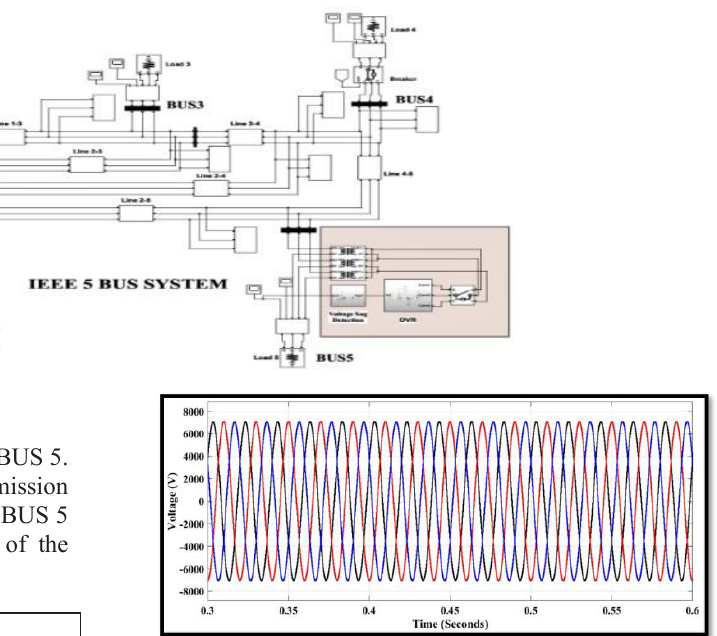
Fig14 Expanded Voltage Waveform